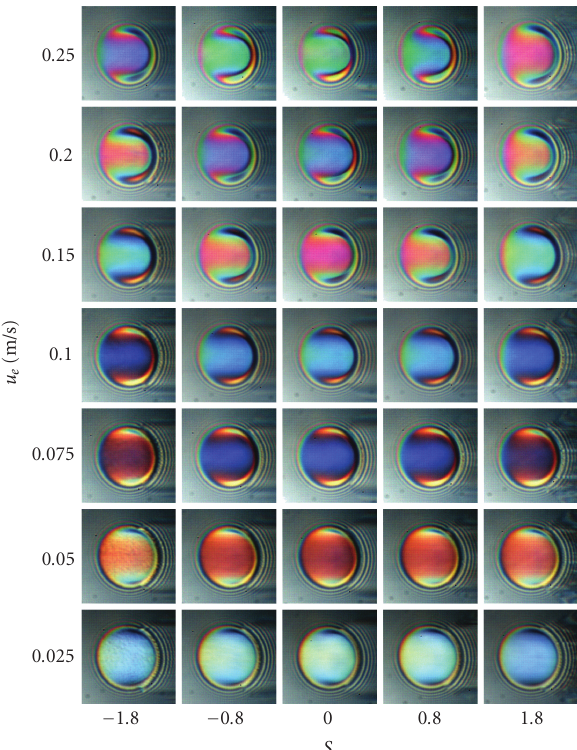
Figure 12: Interferograms obtained under steady-state conditions.